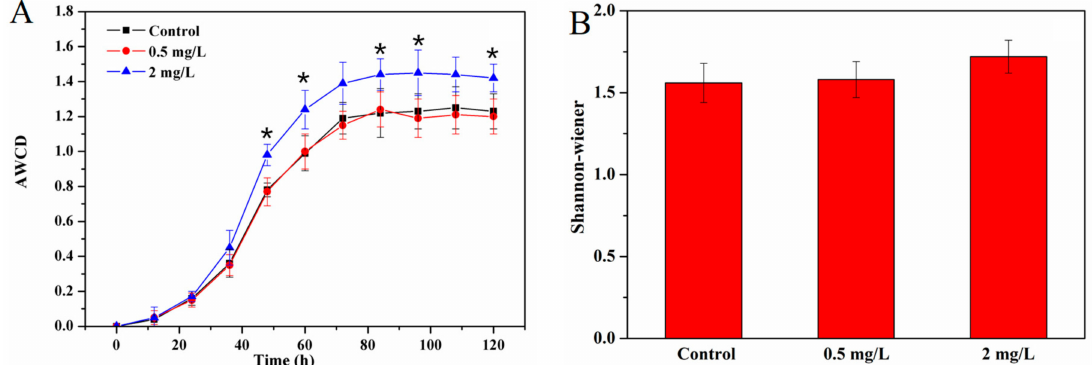
Figure 4. The average well color development (AWCD) of all carbon sources in periphyton communities treated with di ff erent Cu concentrations within incubation time ( A ) and Shannon-Wiener (metabolic diversity indices) for periphyton ( B ). * indicates significant di ff erences at p < 0.05 between the control and Cu 2 +